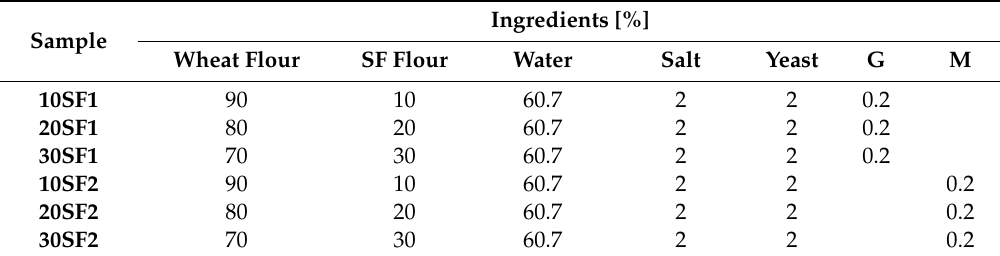
Table 2. Buns recipe by adding sprouted buckwheat